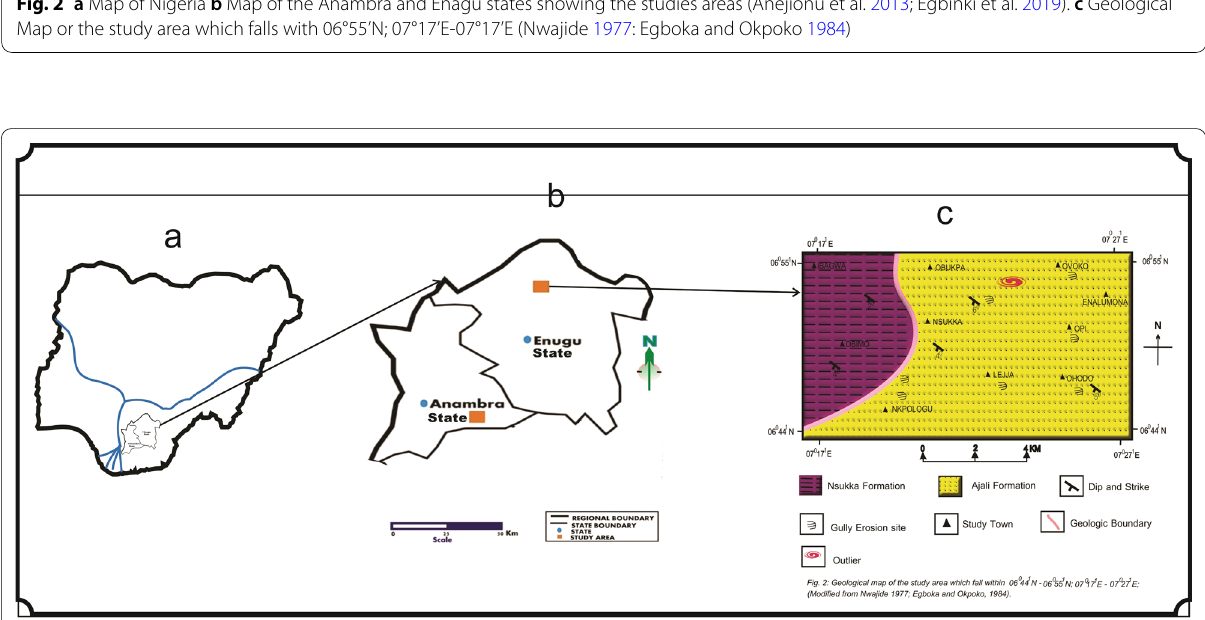
Fig. 3 a Map of Nigeria or b Map of the Anambra and Enagu states showing the studies areas (Anejionu et al. 2013; Egbinki et al. 2019). c Geological Map or the study area which falls within 06°02’N-07°05’N-06°43’E-07°30’E (Nwajide 1977: Egboka and Okpoko